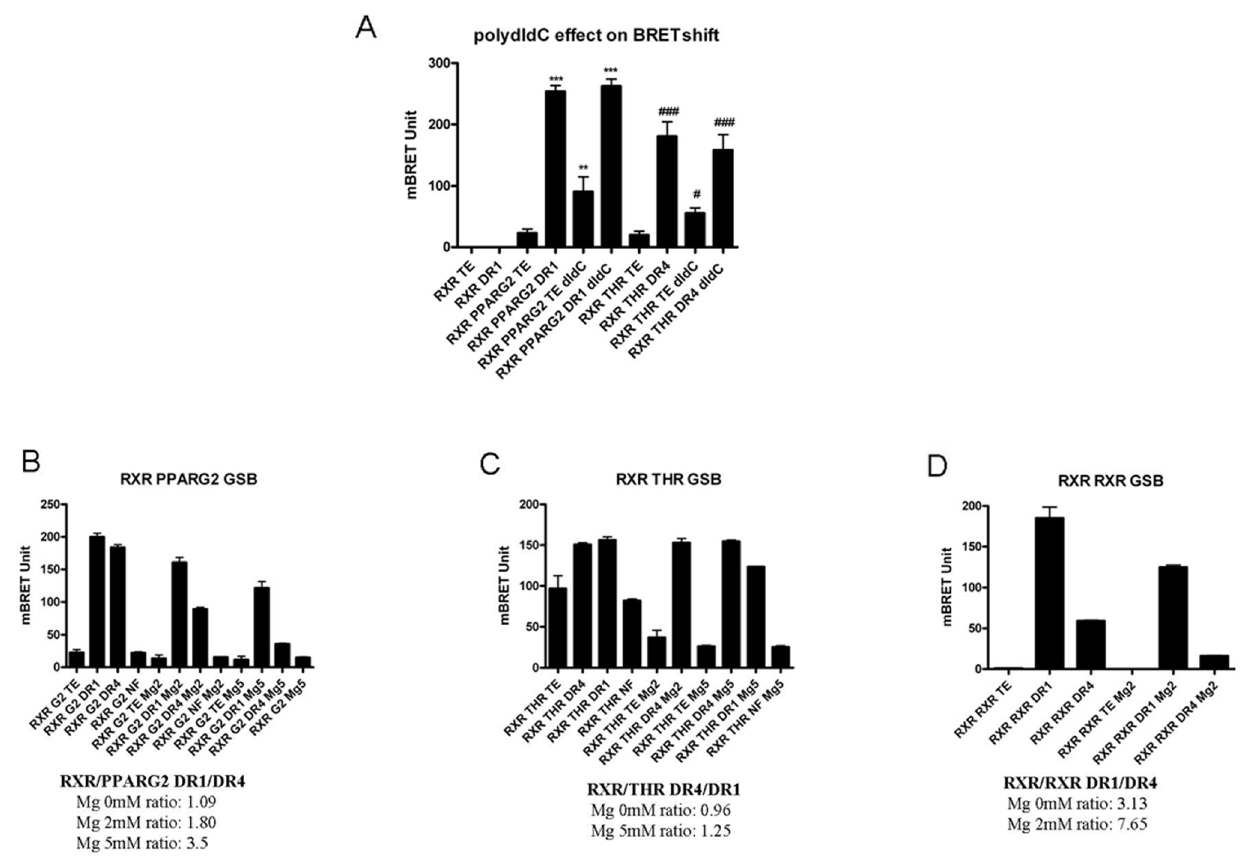
Figure 8. Effect of polydIdC and MgCl 2 on invitro BRET shift assay. (A) Effect of polydIdC addition on RXR/PPARG2 and RXR/THR BRET assay. A BRET shift assay in PLB was performed in presence or absence of polydIdC (50 ng/ m l) and effect on basal BRET and specific DNA RE induced BRET shift was measured for RXR-Luc and PPARG2-EYFP (**P , 0.01; ***P , 0.001), or RXR-Luc and THR-EYFP ( # P , 0.05; ### P , 0.001), Statistical differences relative to control (TE) were analyzed by one-way ANOVA followed by Dunnett’s multiple comparison post hoc test. (B, C and D) Effect of MgCl 2 addition on BRET shift RXR/PPARG2, RXR/THR and RXR/RXR BRET assay. BRET shift experiments were carried out in Gel Shift Buffer (GSB) supplemented with 0, 2 or 5 mM of MgCl 2 . Calculation of the DR1/DR4 BRET shift ratio for RXR/PPARG2 (B), the DR4/DR1 BRET ratio for RXR/THR (C) and the DR1/DR4 BRET ratio for RXR/RXR (D), illustrated the higher specificity of BRET shift observed by increasing MgCl 2 concentration. Histograms represent mean BRET value 6 SD of at least 3 experiments in triplicate. Values represent BRET measures integrated over a 20 min